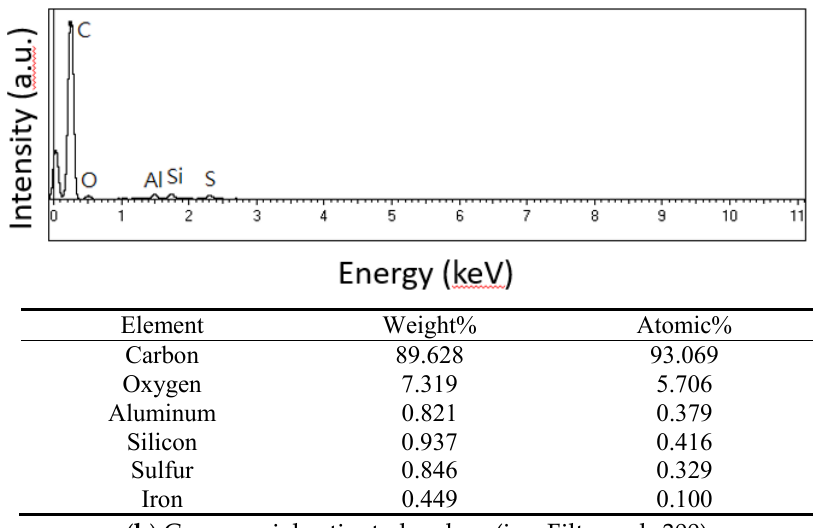
Figure 5. Energy dispersive X-ray spectroscopy spectra of ( a ) CM-AC-700 and ( b ) Filtrasorb-300.